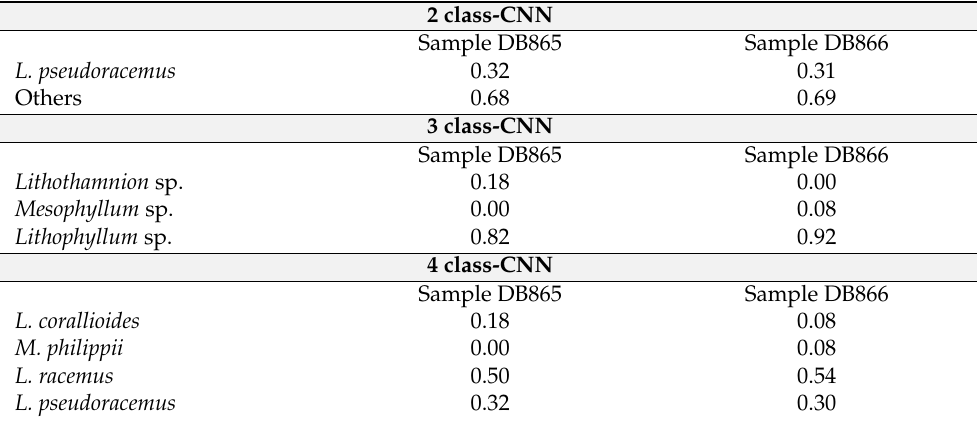
Table 4. Class Share for the L . cf. racemus samples (DB865, DB866) in the 3 classification tasks: L. pseudoracemus versus Others (2 class-CNN), diverse genera (3 class-CNN), and diverse species (4